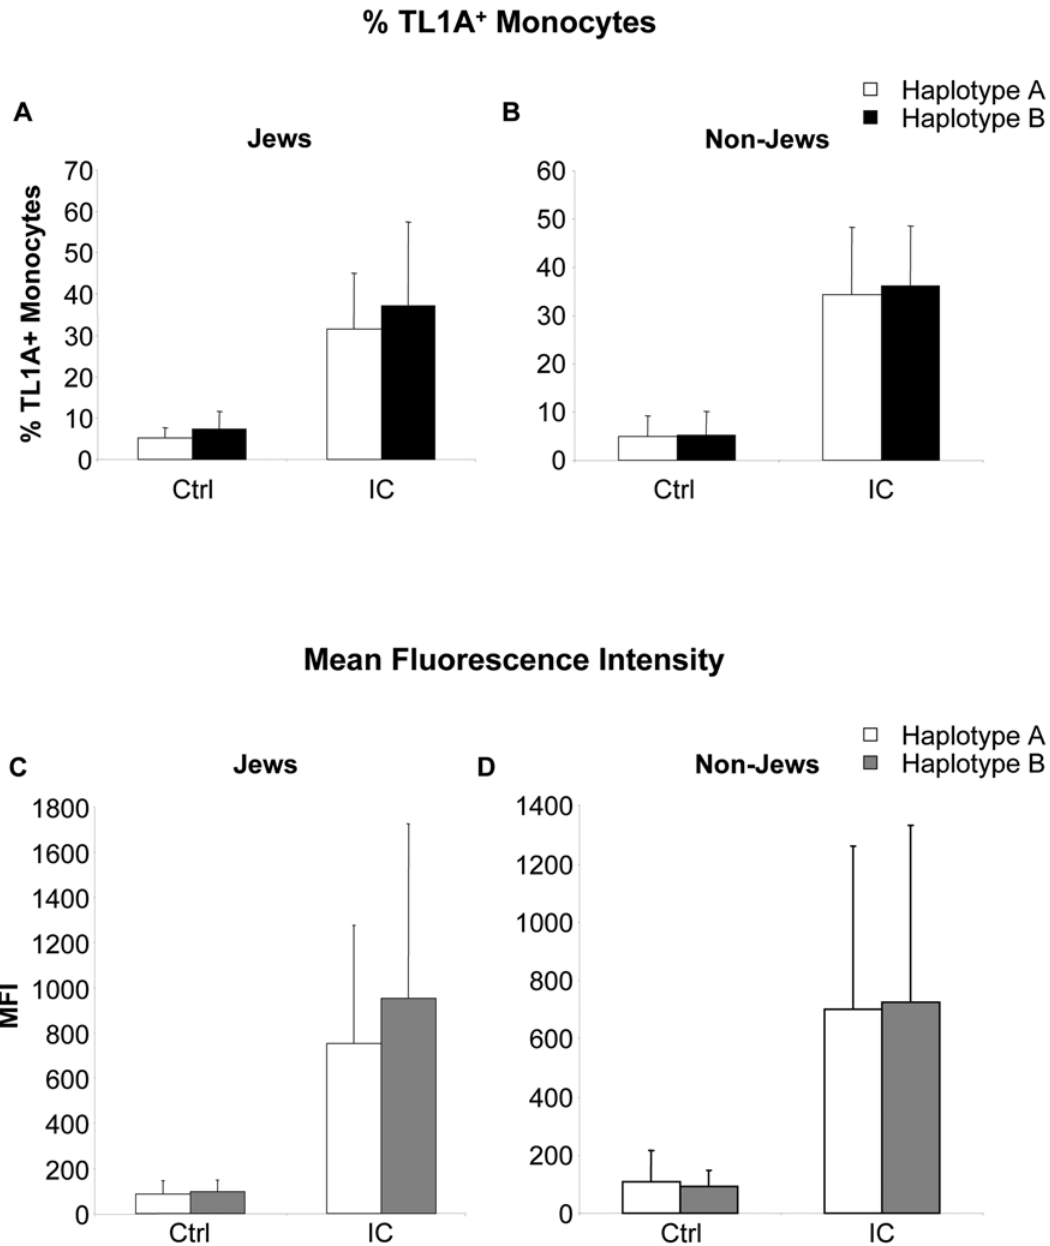
Figure 3. HaplotypeA and B have similar TL1A surface expressions in Jewish and non-Jewish CD patients. ( A ) Monocytes from Jewish patients with A or B haplotypes were stimulated with IC for 16 h. Monocytes were stained with an anti-TL1A antibody and analyzed by flow cytometry. Data are presented as % of TL1A + monocytes (n=11 and 9 for haplotype A and haplotype B , respectively, P=0.19 and P=0.49 for control and IC, respectively). All data represent the mean 6 SD. (B) Monocytes from non-Jewish patients with A or B haplotypes were stimulated with IC for 16 h. Data are presented as % of TL1A + monocytes (n=14 and 16 for haplotype A and haplotype B , respectively, P=0.83 and P=0.72 for control and IC, respectively). (C) Monocytes from Jewish patients with A or B haplotypes were stimulated with IC for 16 h. Data are presented as mean fluorescence intensity (MFI) (n=11 and 9 for haplotype A and haplotype B , respectively, P=0.66 and P=0.52 for control and IC, respectively). (D) Monocytes from non-Jewish patients with A or B haplotypes were stimulated with IC for 16 h. Data are presented as mean fluorescence intensity (MFI) (n=14 and 16 for haplotype A and haplotype B , respectively, P=0.56 and P=0.91 for control and IC, respectively).